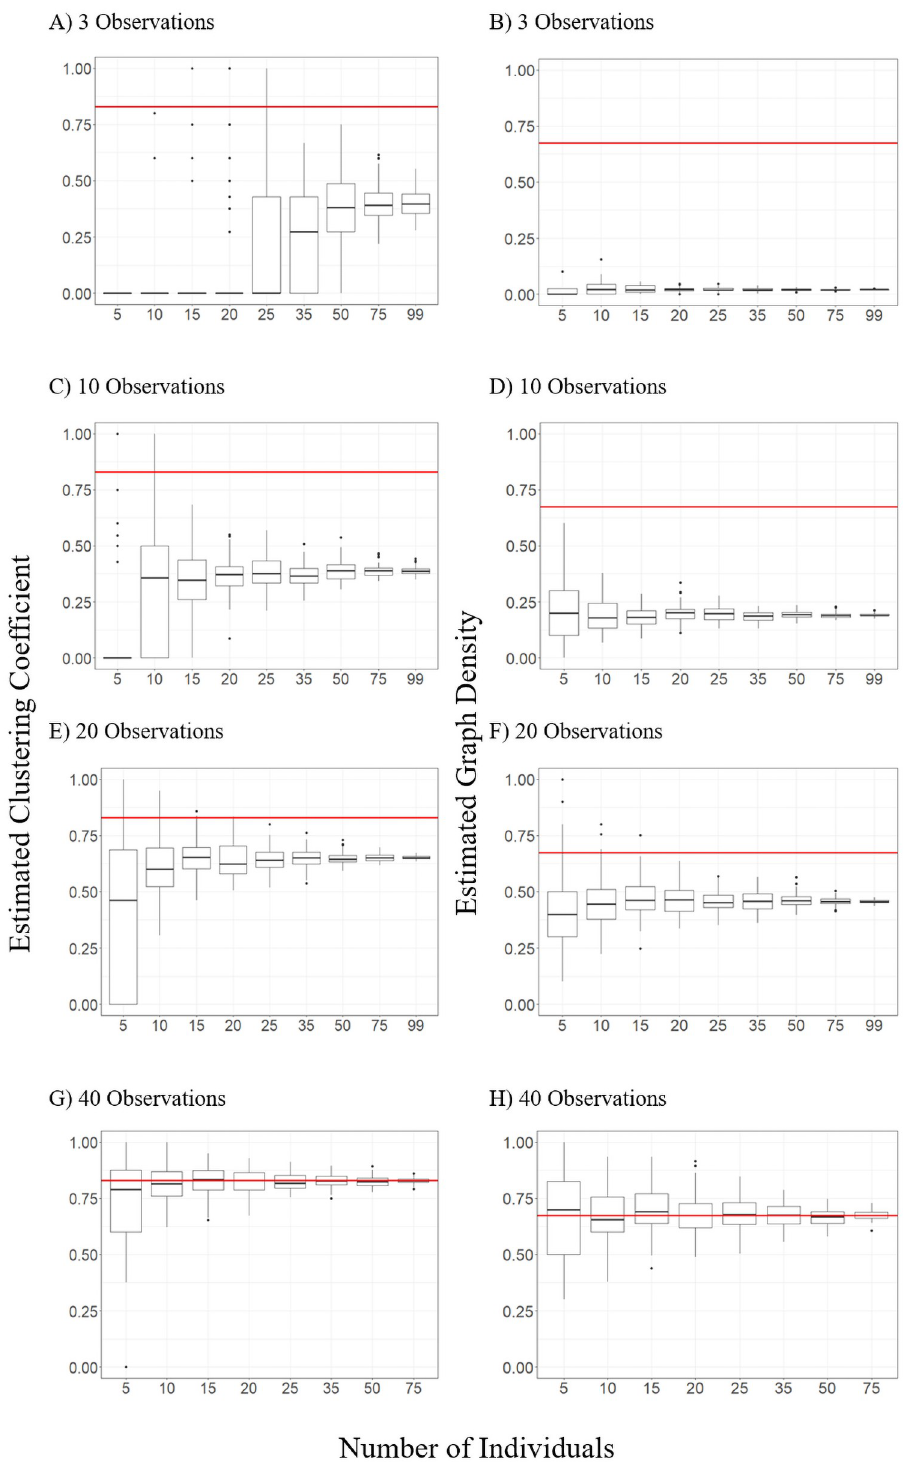
Fig 2. Influence of number of individuals and number of observations per individual on estimates of network clustering coefficient (panels A, C, E, and G) and graph density (panels B, D, F, and H). Boxes represent the 25 th to 75 th percentile of values with the center line representing the median value. The horizontal red line indicates observed values of graph density (0.675) and clustering coefficient (0.828) based from the ‘observed’ network. Full figures for each measure with all tested numbers of observations per individual can be found in S1 and S2